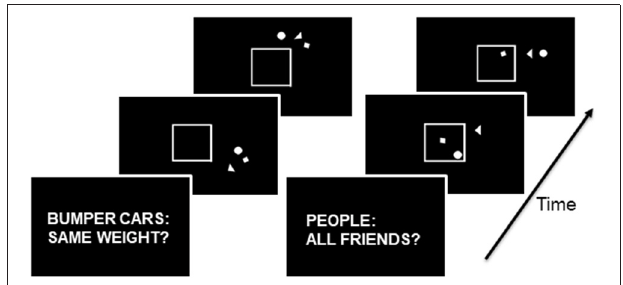
FIGURE 1 | On the left, the progression of stimuli in the Bumper condition: the three shapes move around the middle box with occasional bumps, and the box may open and close during the movements. On the right, the progression of stimuli in the Friends condition: the three shapes move toward and away from each other and in and out of the box which may open and close. During the Bumper condition, the subject engages in visuospatial decision-making. During the Friends condition, the subject engages in social cognitive